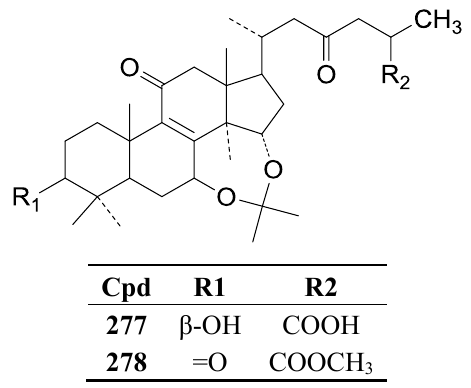
Figure 30. Structures of compounds 277 – 278 .